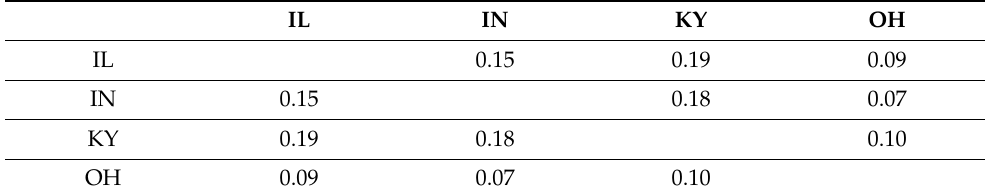
Table 2. Fst values among the breeding lines of four soft red winter wheat programs: IL, IN, KY, and OH.